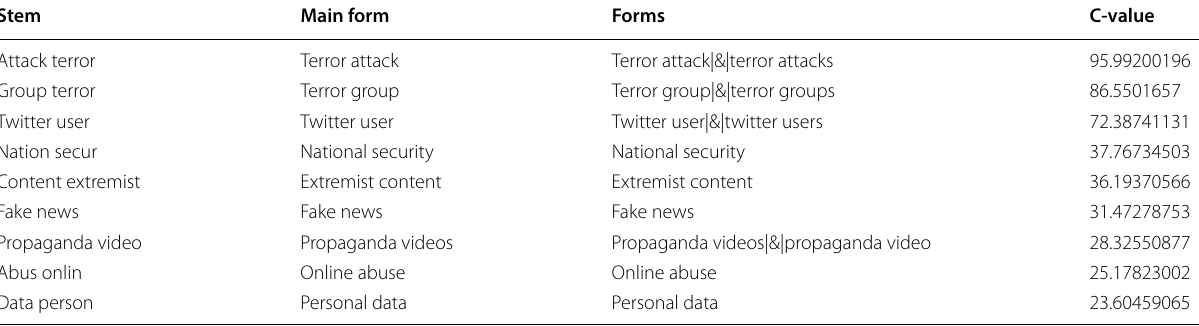
Table 6 C-value on topics presented by actors in newspapers Stem